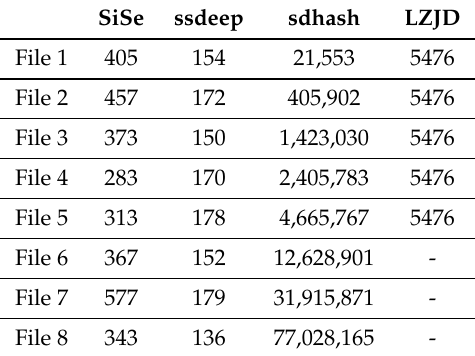
Table 27. Signature size in bytes with the set of eight files